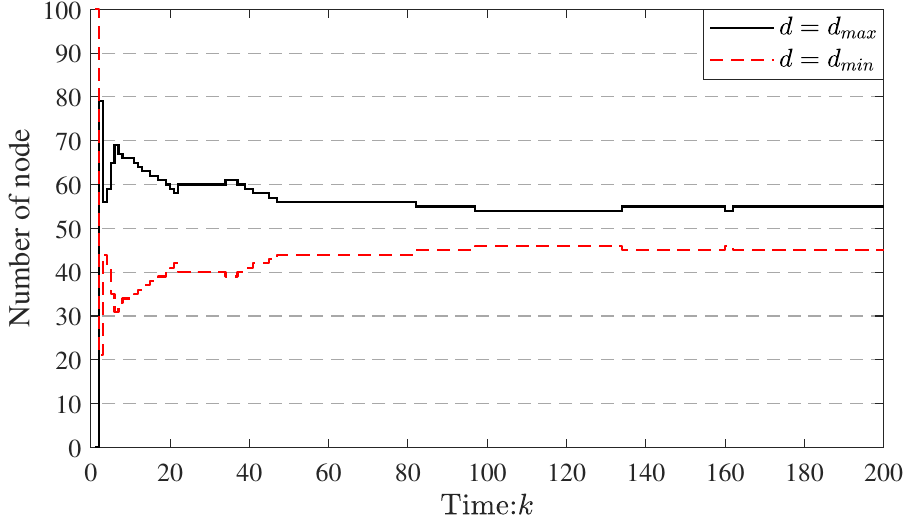
Figure 9. The number of nodes used at different communication distances at every time k